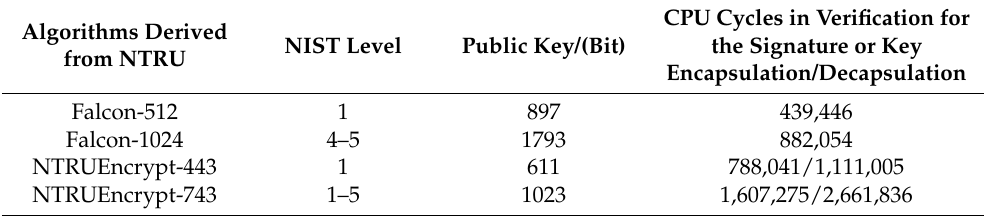
Table 3. Comparison of time overhead between Falcon signature algorithm and NTRUEncrypt algorithm